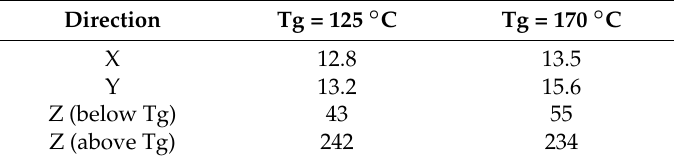
Figure 9. Test plan for the molding trials starting from top-left. A successful molding trial was to be followed by the green arrow and an unsuccessful molding trial was to be followed by the red arrow. Table 4. Comparison of the CTE values of the two PCB variants (ppm/K).